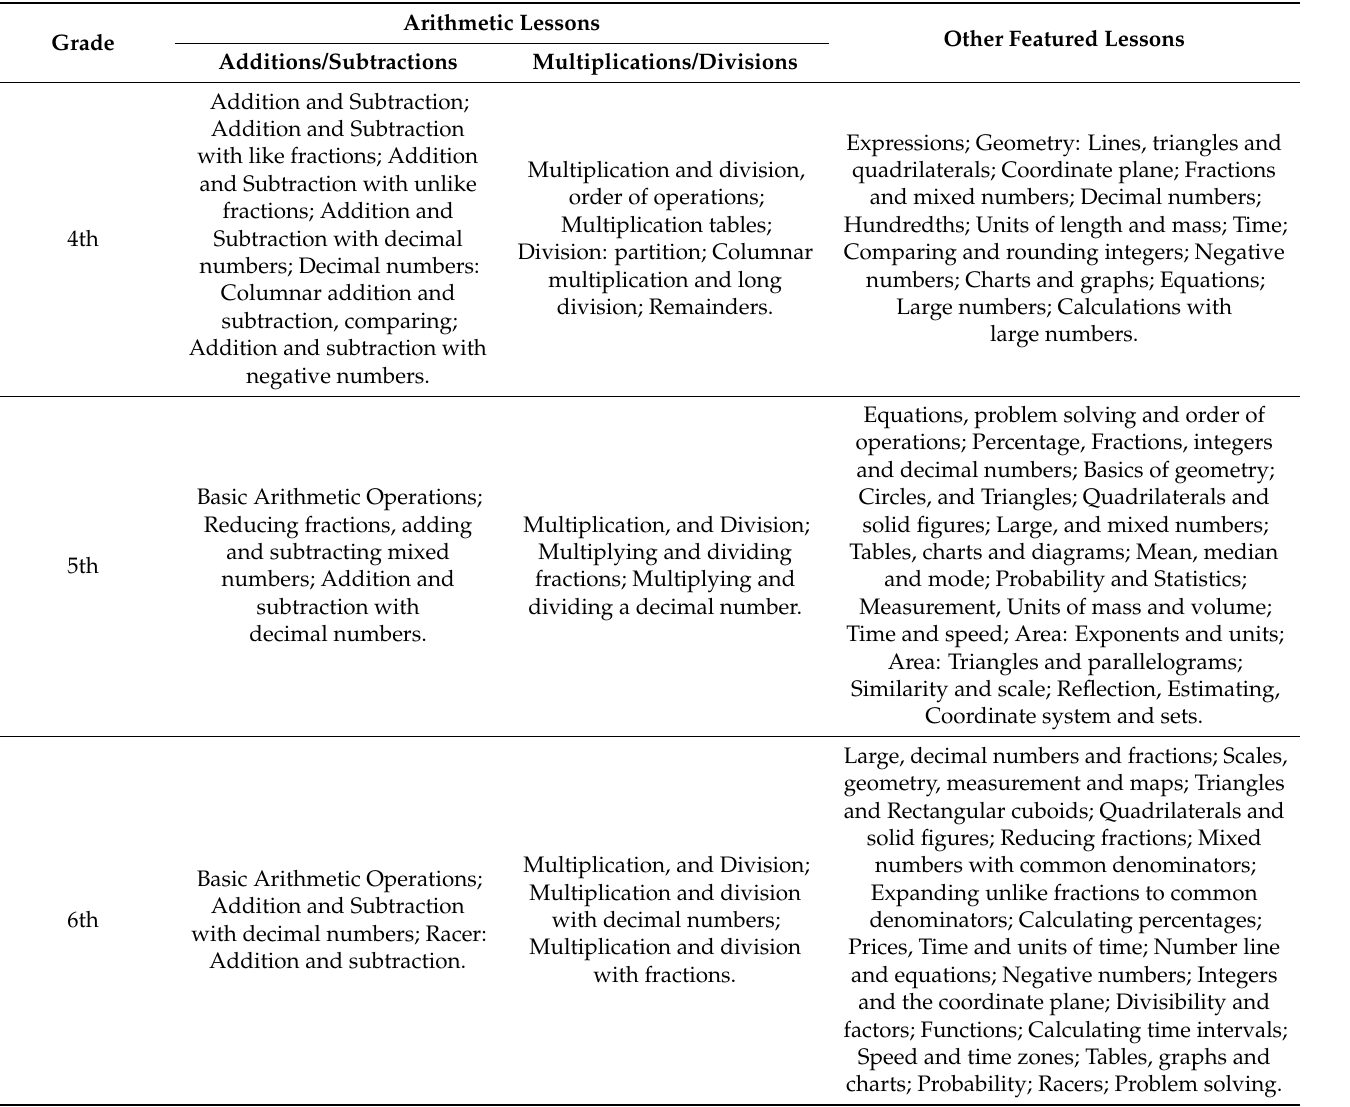
Table 1. Overview of the curriculum